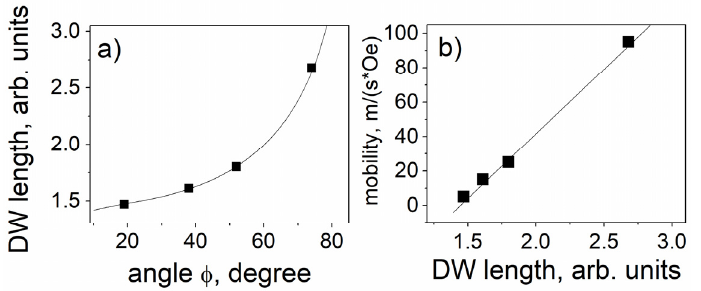
Figure 13. Dependence of DW length of angle of inclination ( a ) and dependence of mobility on DW length in elliptic domain wall. ( a ) Line—results of the calculation (Equation (1)) and points taken from the experiments. ( b ) experimental points. Reprinted with permission from [99].